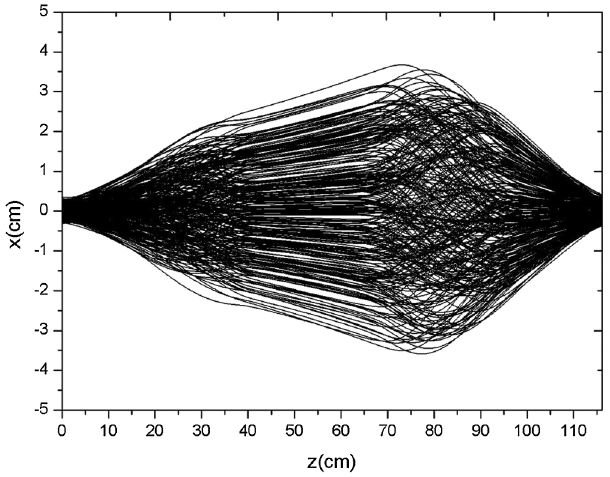
FIG. 5. Trajectories along the LEBT simulated by BEAMPATH .